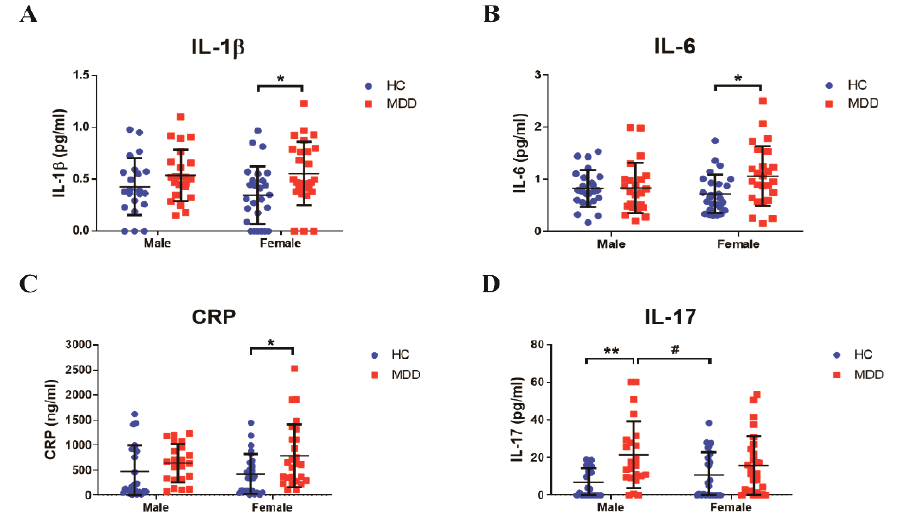
Figure 2. Different tendencies of inflammatory biomarkers between males and females. ( A ) IL-1β, ( B ) IL-6, ( C ) CRP, and ( D ) IL-17 were analyzed using the serum of participants. n = 23–27 for each group. * p < 0.05 and ** p < 0.01 vs. control male group, # p < 0.05 vs. control female group by two-way ANOVA test. Data are presented as means ± SD.